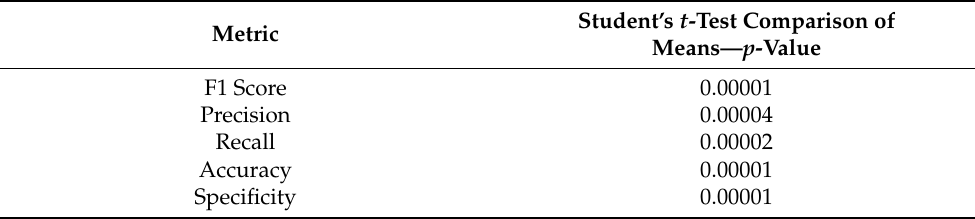
Table 8. Means comparison hypothesis test for dataset ISIC 2017.